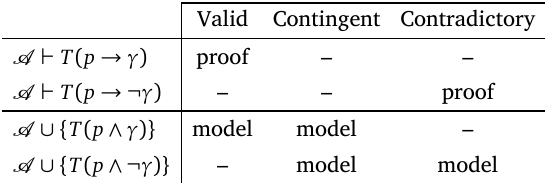
Maximal possible output for valid, contingent, and